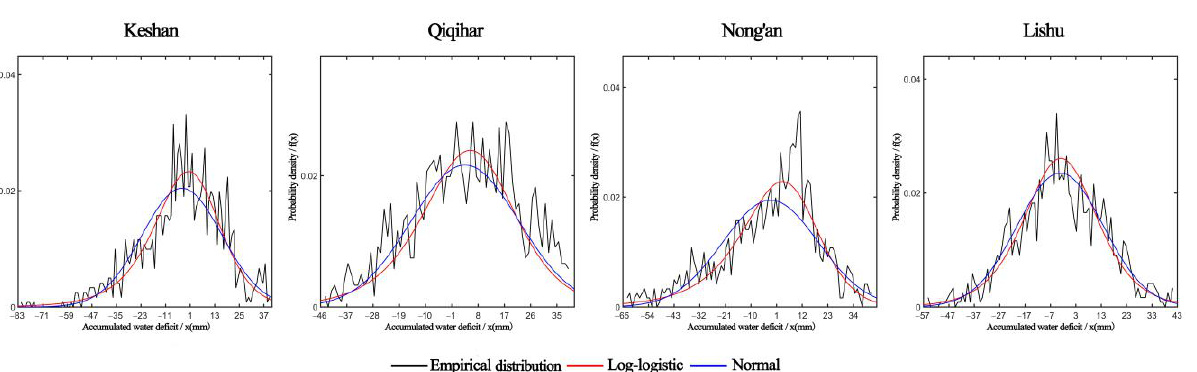
Figure 2. Comparison of three function fitting curves of crop water deficit sequence: ( a ) density curves and ( b ) distribution curve. Similarly, from the distribution curve (Figure 2b), the coincidence degree of the three parameter Log - logistic distribution curve and the empirical distribution curve was relatively high. So the time series of cumulative crop water deficit of spring maize in Songnen Plain obeyed three parameter Log - logistic distribution, and it was feasible to fit and standardize it. 3.1.2. Comparison of Different Drought Indexes in Time Series The commonly used drought indexes (Pa, MI, SPI, SPEI, CWDI, and CWDIa) in the study area from 1981 to 2018 were calculated to test the applicability of SCWDI. Among these indexes, SCWDI has the same meaning as CWDI and CWDIa. The larger the index value, the more serious the drought. However, it is opposite to the meaning of Pa, MI, SPI, and SPEI, that is, the smaller the index value, the more serious the drought. From the perspective of time series (Figure 3), although there were differences in each drought index, it can reflect the dry and wet state of spring maize in different years at various growth stages. The drought period shown by SCWDI was consistent with other drought indexes and can reflect the typical drought years, such as 1982, 1989, 2001, 2004, 2007, 2017, and so on. However, there were differences in the monitoring results of each index. In 1982, the drought severity period of spring maize reflected by SCWDI was consistent with that reflected by SPI and CWDIa; in 1989, it was consistent with the drought period reflected by MI, CWDI, and CWDIa; in 2001, it was consistent with the drought period reflected by CWDI and CWDIa; in 2004, it was basically consistent with other drought indexes except that it was different from MI; in 2007, it was consistent with the drought period reflected by SPI, SPEI and CWDIa; and in 2017, it was consistent with the drought period reflected by SPI and CWDIa. In general, the drought periods identified by SCWDI in the drought monitoring of spring maize can be consistent with the commonly used drought index.